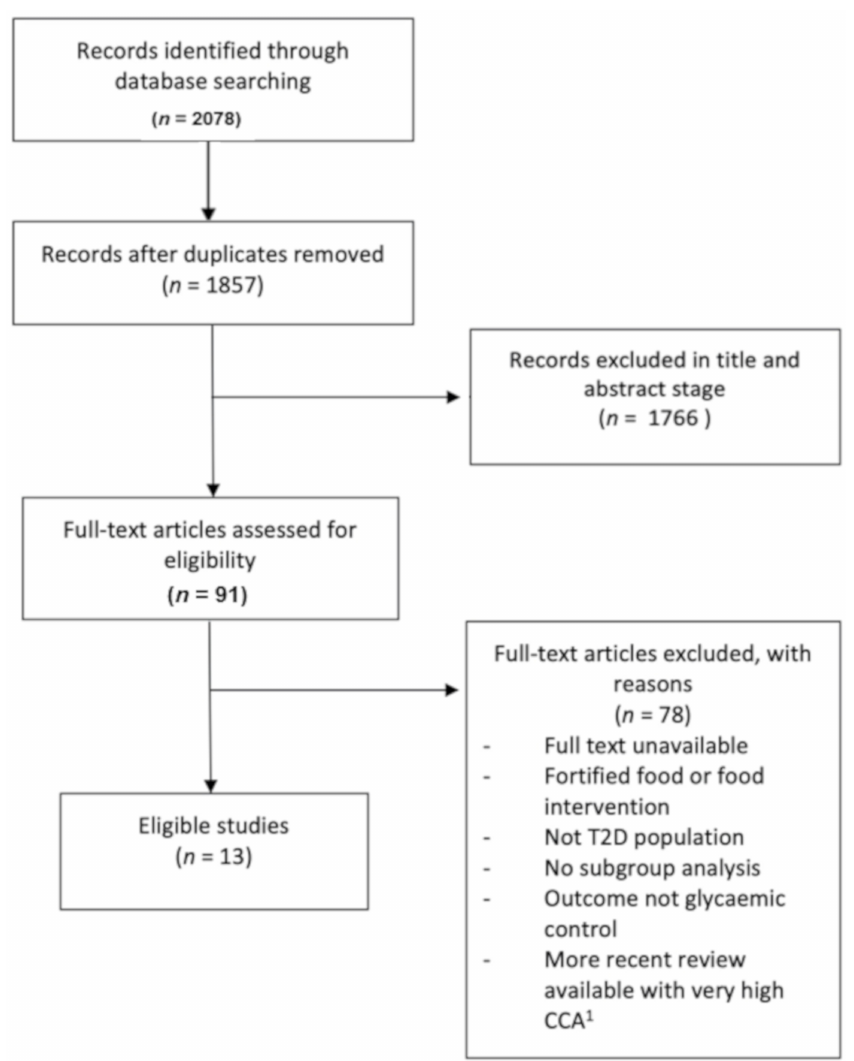
Figure 1. Flow chart of search results. 1 Corrected Covered Area: degree of overlap between